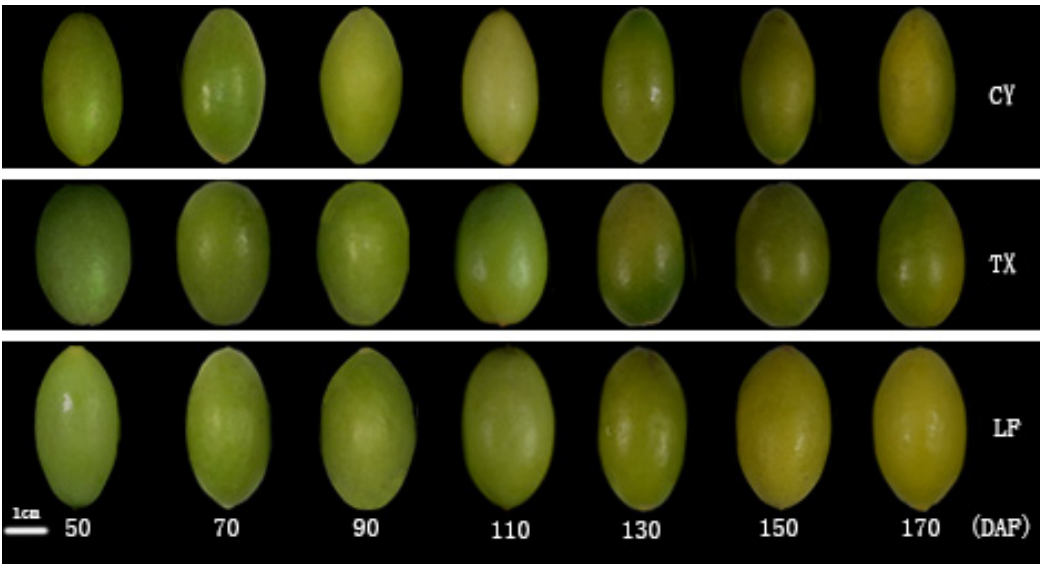
Figure 3. Chinese olive fruit at different developmental stages. CY, ‘Changying’, TX, ‘Tanxiang’, LF, ‘Lingfeng’. DAF, days after flowering.